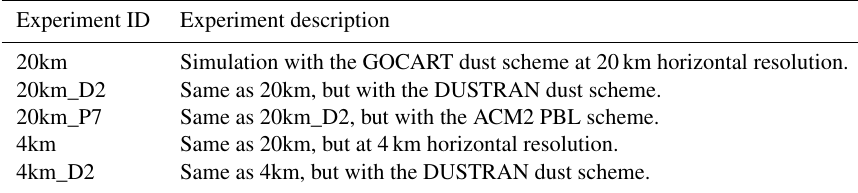
Table 1. Experiment description. Experiment